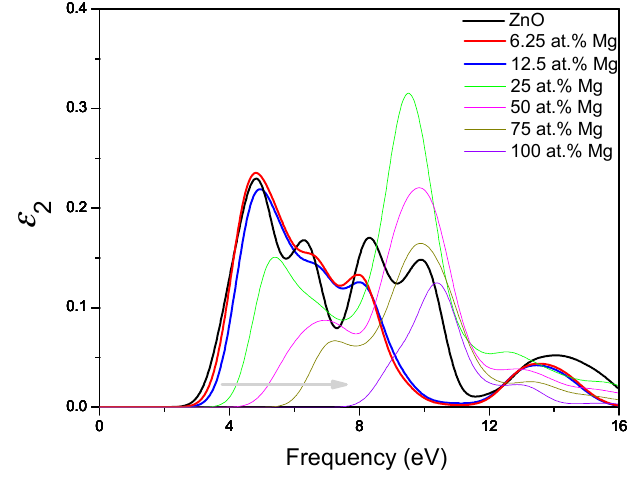
Figure 6. The imaginary part of dielectric function of MgZnO monolayer.